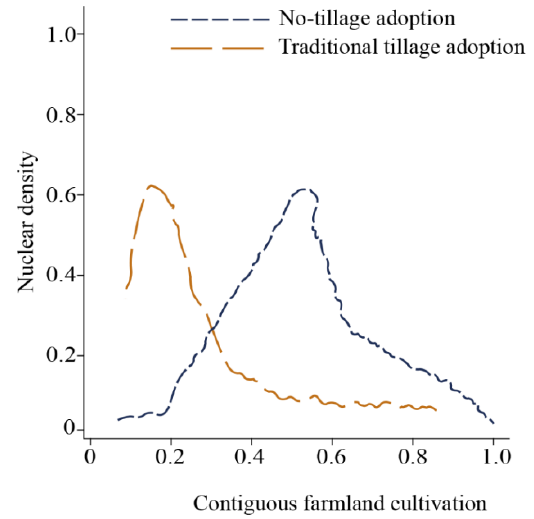
Figure 3. Nuclear density curve between the contiguous farmland cultivation and transferees’ adoption of no-tillage technology (Source: field survey 2019).